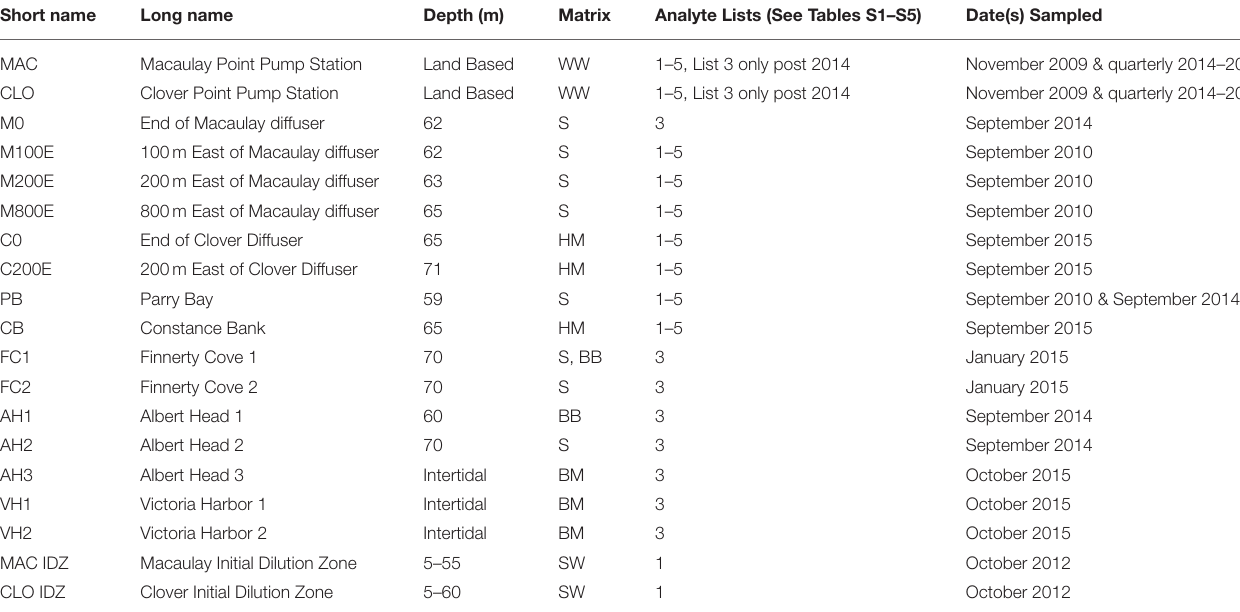
TABLE 1 | Sampling